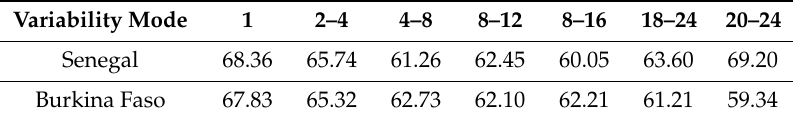
Table 3. Percentage of consistency between precipitation and the AMO index (%).